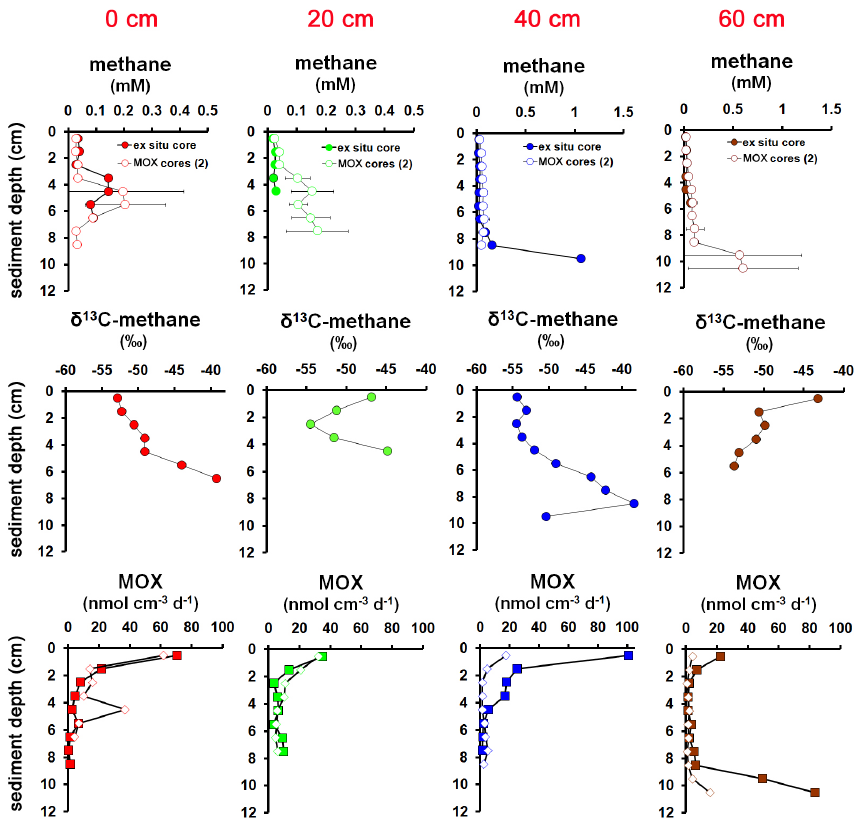
Fig. 2b. Biogeochemical profiles of the November sampling (transect) at Brian Seep: methane, δ 13 C-methane, and methane oxidation (MOX, 2 replicates). Methane profiles show methane concentrations of samples taken immediately after recovery (ex-situ core) or after 24h incubation (MOX cores, no. of replicates provided in legend, S.D. bars are given). Methane concentrations are presented in mmolL − 1 sediment. Distances from gas vent: 0 (red), 20 (green), 40 (blue), and 60cm